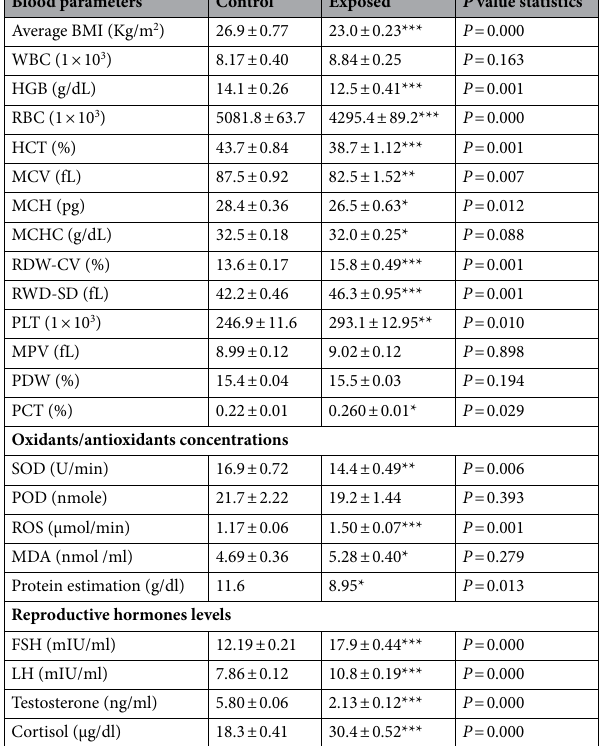
Table 4. The effects of heavy metal burden on BMI, blood parameters, biochemical profile, and reproductive hormones concentration of brick kiln male workers and controls. Values are expressed as mean ± SEM. *, **, *** indicates significant difference at probability p < 0.05, p < 0.01 and p < 0.001 compared to